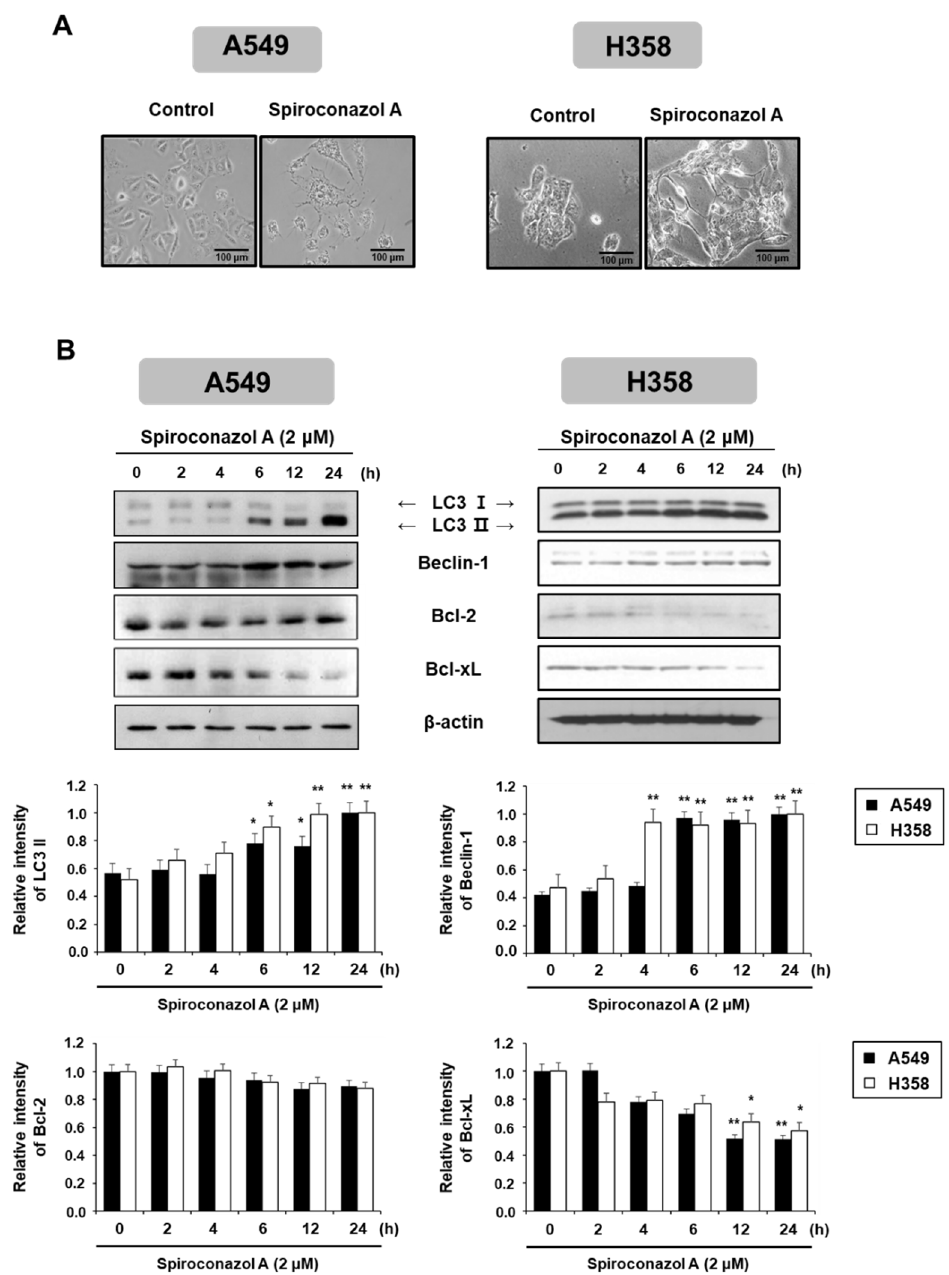
Figure 2. Autophagy induced by spiroconazol A in NSCLC cells. ( A ) Representative images showed the morphological changes in spiroconazol A (2 µ M)-treated NSCLC cells using an OLYMPUS IX51 inverted microscope (Southend-on-Sea, Essex, UK). ( B ) Protein expression of cells exposed to 2 µ M of spiroconazol A, using Western blot analysis. β -actin was utilized as an internal control. The relative optical density ratio was determined using a densitometric analysis program (Bio-Rad Quantity One ® Software, version 4.6.3 (Basic), Bio-Rad Laboratories Inc., CA, USA), normalized to the internal control. * p < 0.05, ** p < 0.01 vs. untreated A549 cells, by the Student’s t